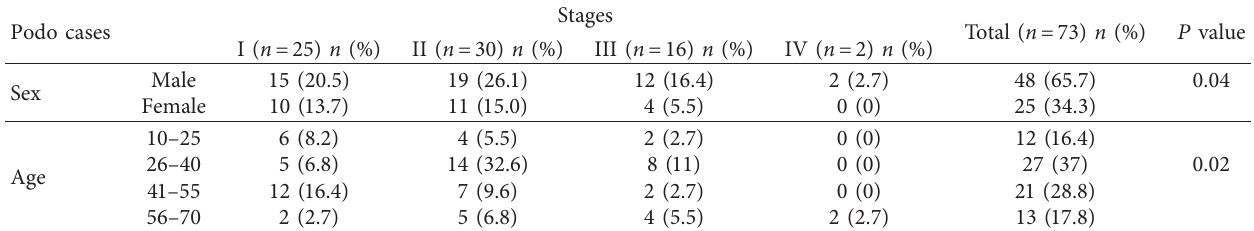
Table 3: Stages of podoconiosis cases ( n � 73) in Jeldu district, West Shoa,